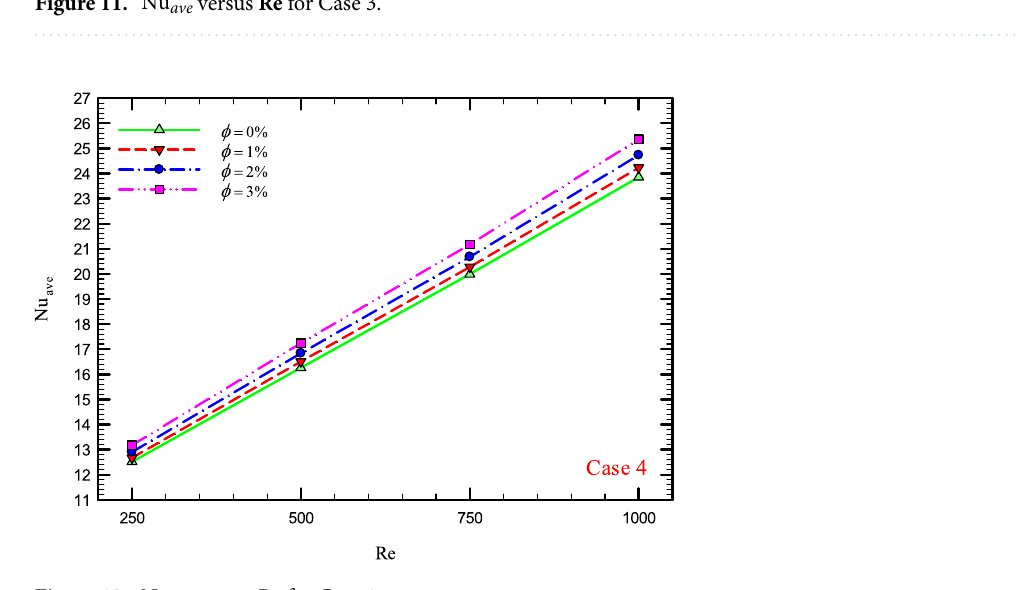
Figure 12. Nu ave versus Re for Case